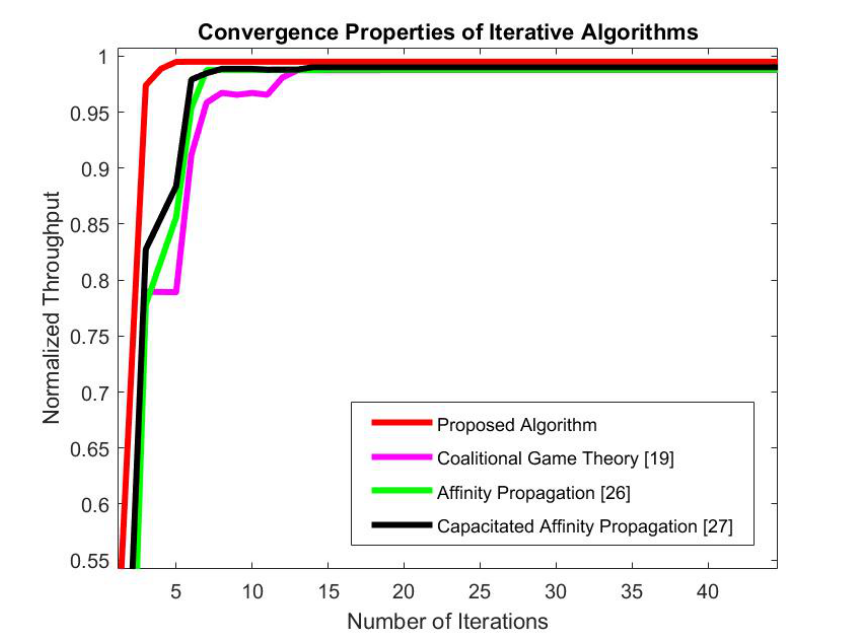
Figure 8. Convergence properties of iterative